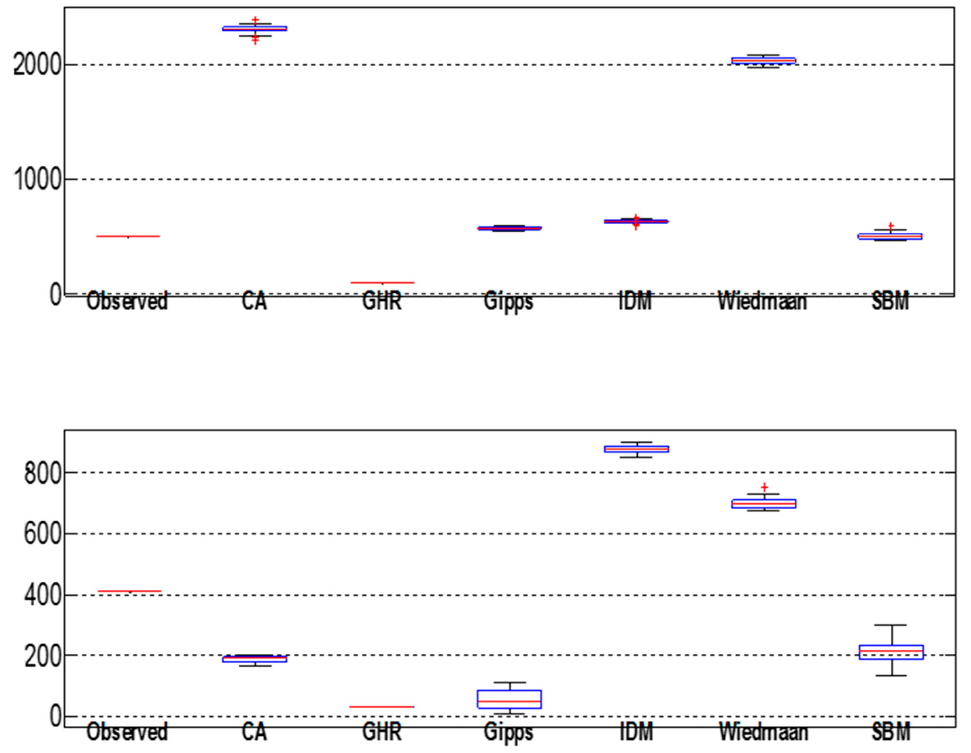
Figure 5. Short TTC and Headway frequency reproduction in different CF models, at I-80 road trajectory data.